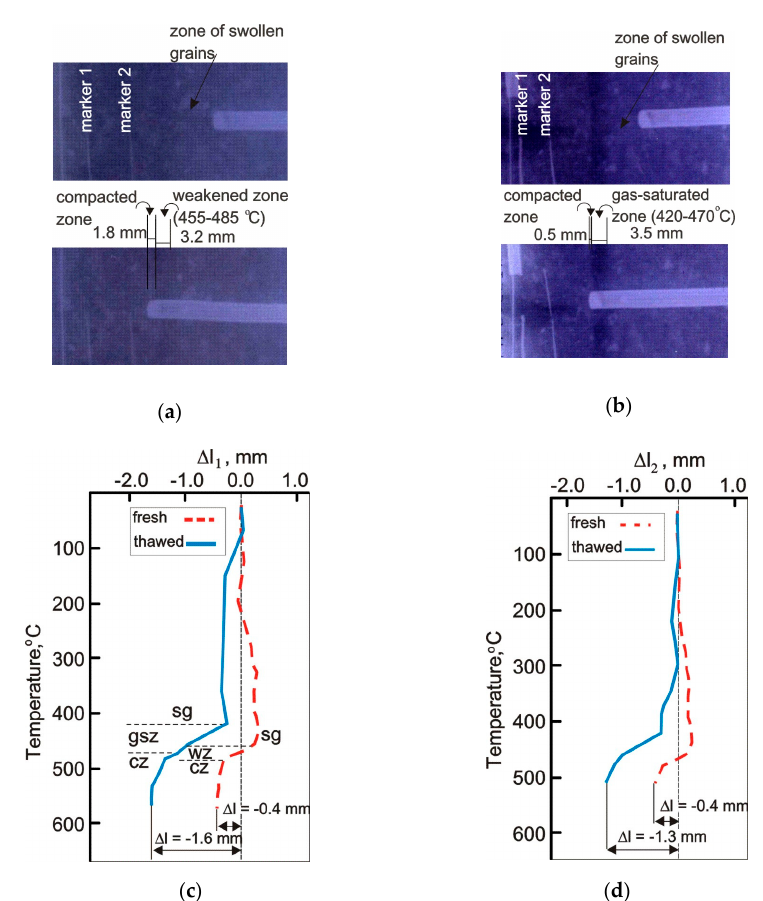
Figure 3. X ‐ ray images of heated charges of fresh ( a ) and thawed ( b ) coals along with the changes in position of marker 1 ( c ) and marker 2 ( d ) in the heated coal charges; sg—swollen grains, wz—weakened zone, gsz—gas ‐ saturated zone, cz—compacted zone.